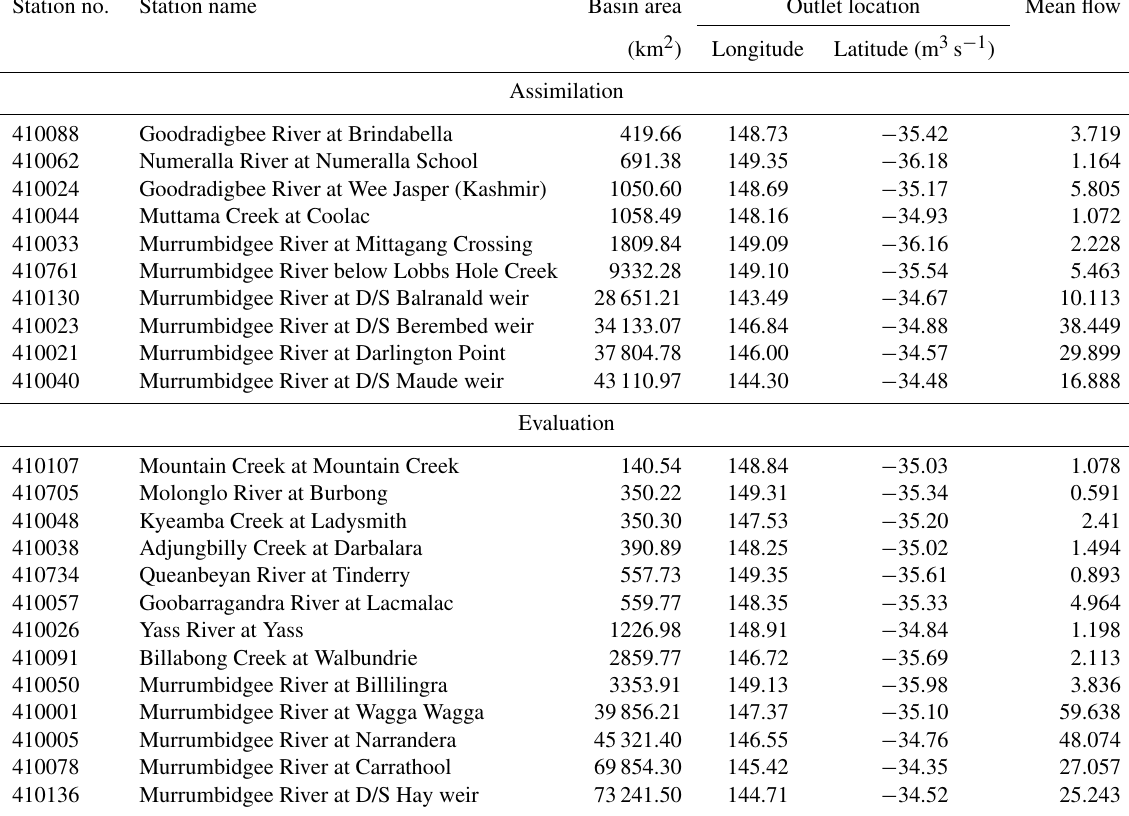
Table 3. Hydrometeorological and geographical information of analysed catchments at the Murrumbidgee River basin. Station